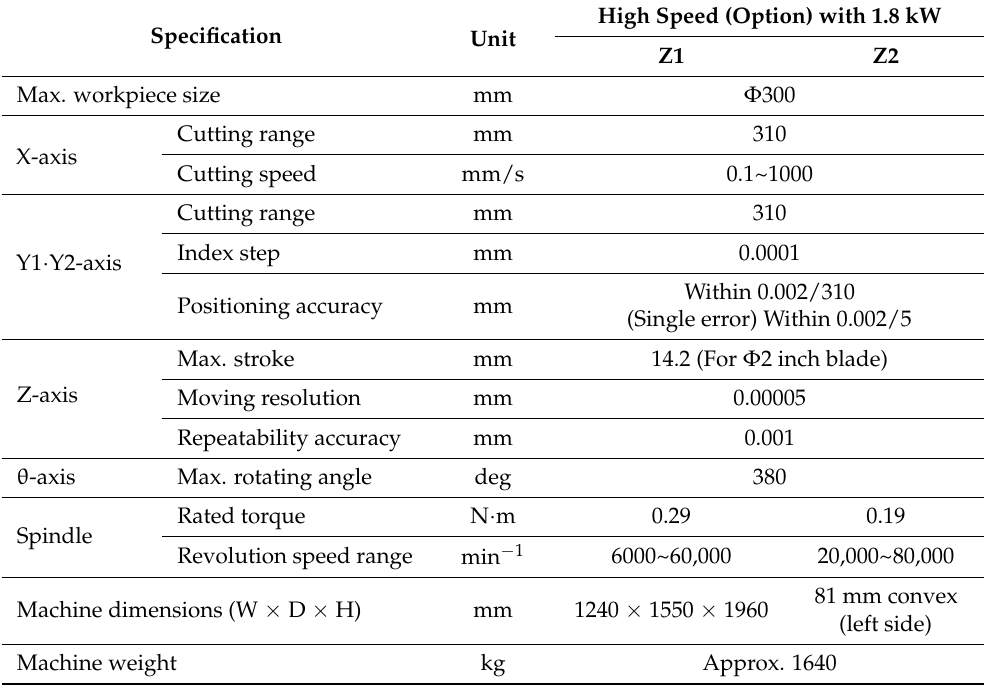
Figure 21. Production machine DISCO DS6560. Table 1. Specifications of DISCO DS6560.